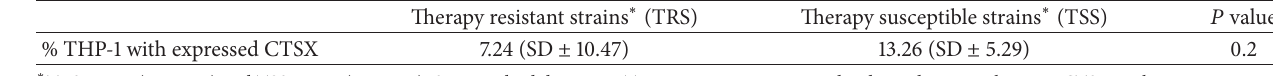
Table 1: Expression of CTSX on THP-1 cells after stimulation with different H. pylori antigens.